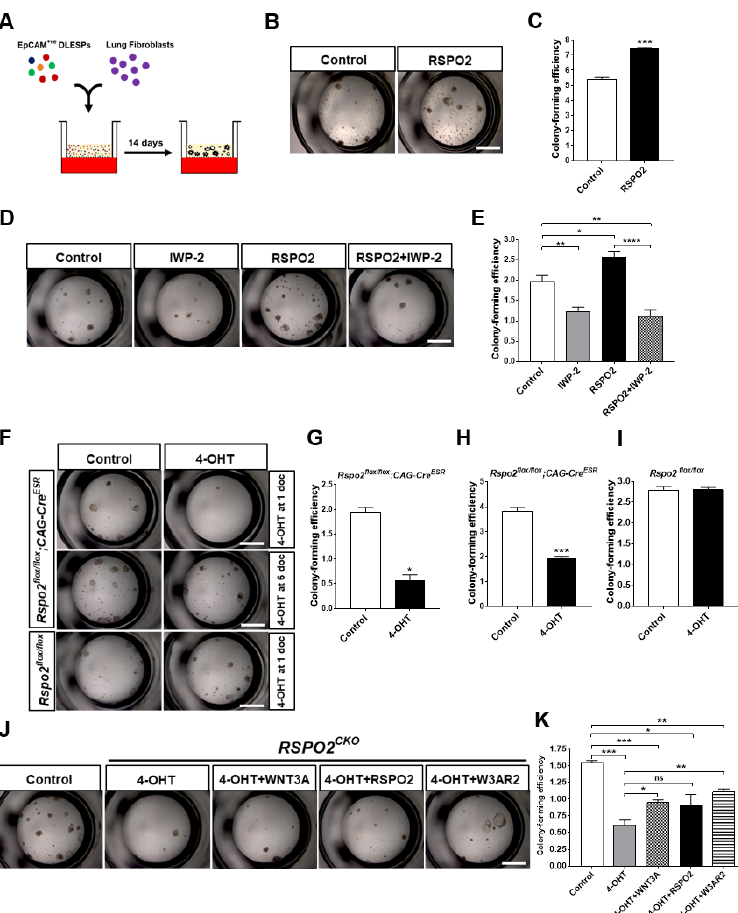
Figure 2. Rspo2 is essential for the colony formation of DLESPs in ex vivo 3D organoid culture. ( A ) Schematic diagram of ex vivo air–liquid interface (ALI) 3D organoid culture. ( B , C ) Bright-field images and quantification showing the effect of RSPO2 protein treatment (200 ng/mL) on colony formation of DLESPs in the organoid culture for 14 days. ( D , E ) Bright-field images and colony-forming efficiency of DLESPs showing the effect of WNT protein secretion blocker, IWP-2 (5 μM), in the organoid culture treated for 14 days. ( F ) Bright-field images of Rspo2 CKO DLESP-derived organoids after 14 days of culture. Inactivation of Rspo2 was achieved by 4-OHT (500 nM) treatment for the first two days of organoid culture. ( G , H ) Colony-forming efficiency of Rspo2 CKO DLESPs. The cells were treated with 4-OHT (500 nM) for the first two days ( G ) or at culture day 6 for two days ( H ). ( I ) No 4-OHT effect on colony-forming efficiency of control Rspo2 flox/flox DLESPs. 4-OHT treatment was administered for the first two days of the organoid culture and data were collected at day 14. ( J , K ) Bright-field images and colony-forming efficiency showing the rescued effects of WNT3A (20 ng/mL), RSPO2 (200 ng/mL), or W3AR2 (RSPO2 + WNT3A) protein treatment on Rspo2 CKO DLESPs organoid formation. Data are presented as mean ± SEM. ns: no statistical significance, * p < 0.05, ** p < 0.01, *** p < 0.001, **** p < 0.0001.